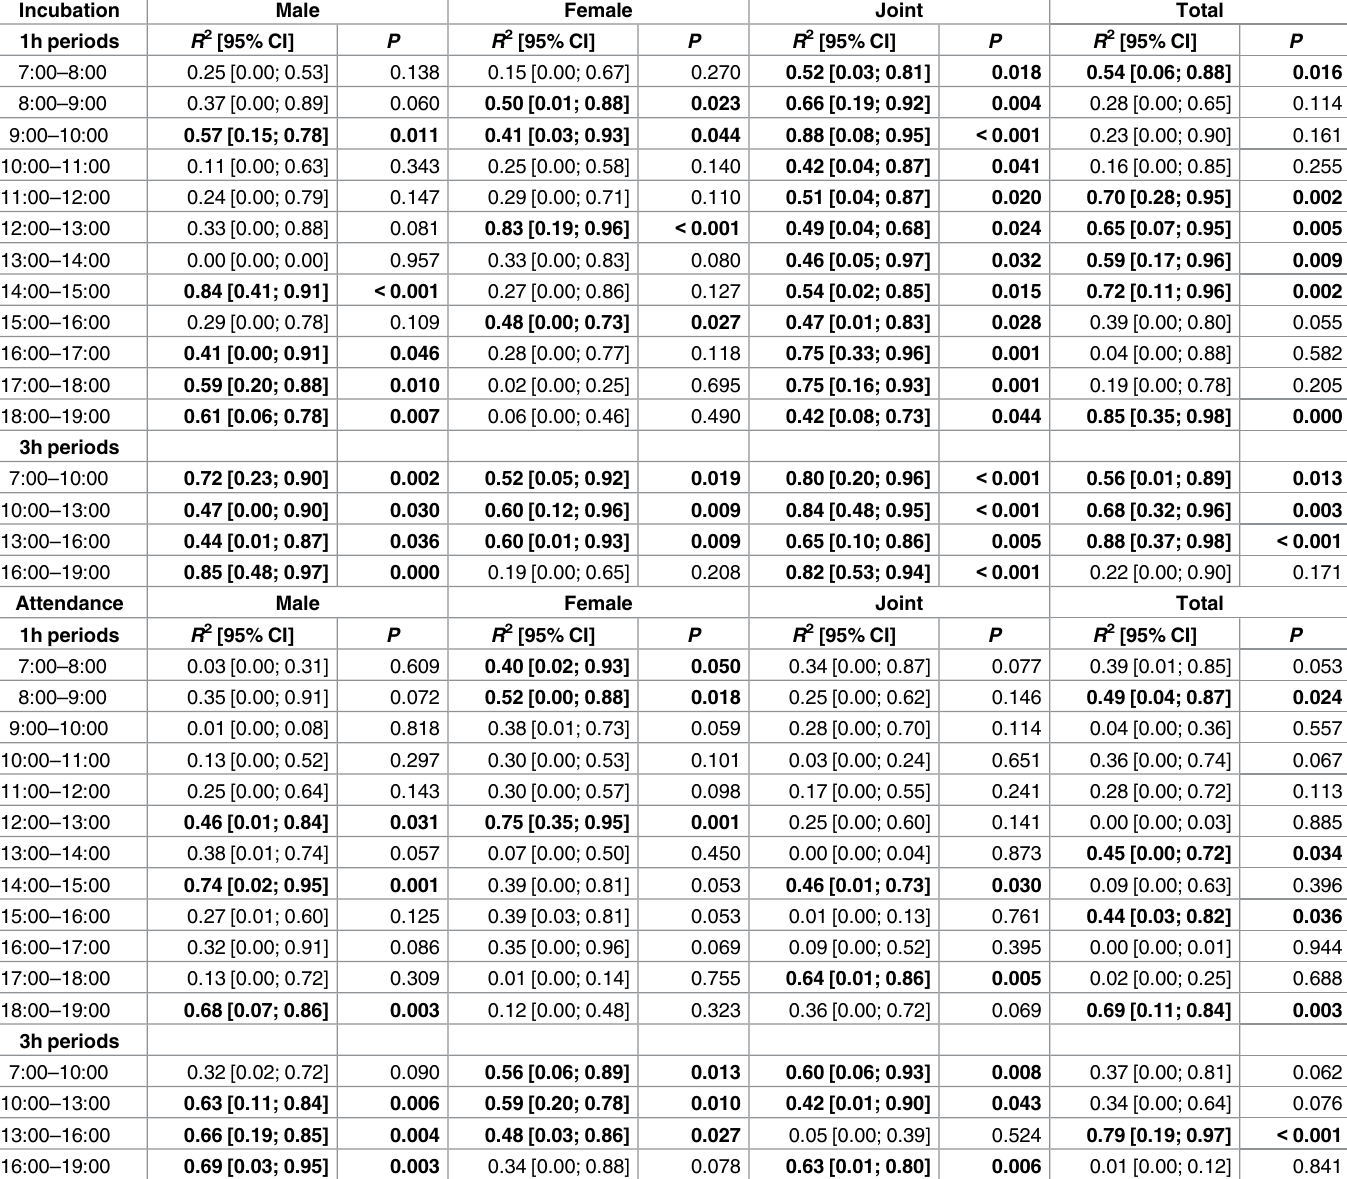
Table 2. Overall daily incubation and nest attendance of ten zebra finch pairs on day 3 of incubation predicted by a series of 1h and 3h sampling periods.